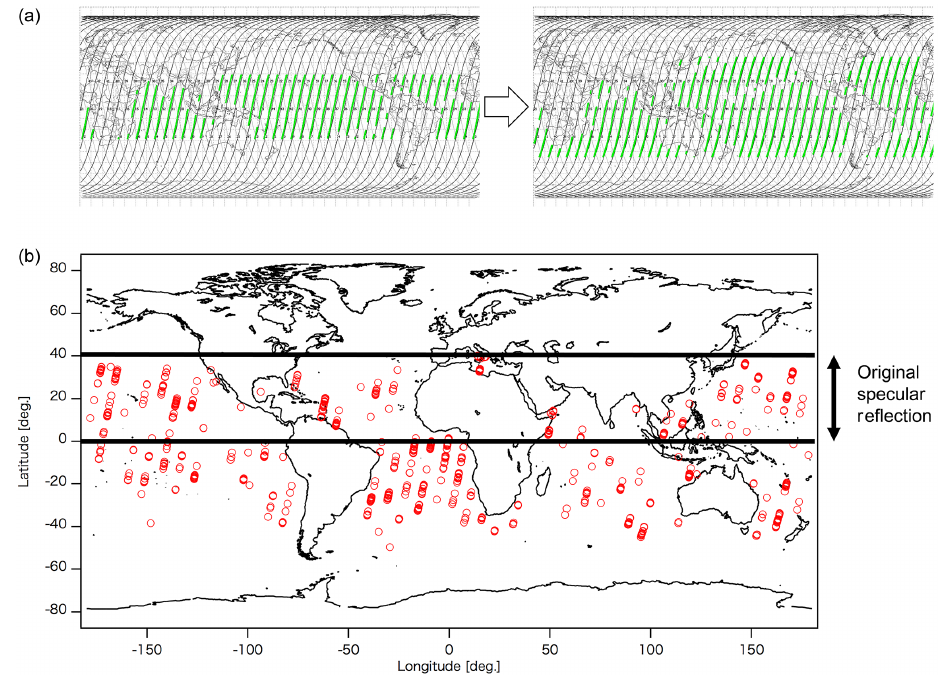
Figure 15. (a) Glint observation area extension by tracking along the principal plane of reflection before (left) and after (right) 10 Septem- ber 2014; (b) clear-sky data point distribution after extension during 7–9 June